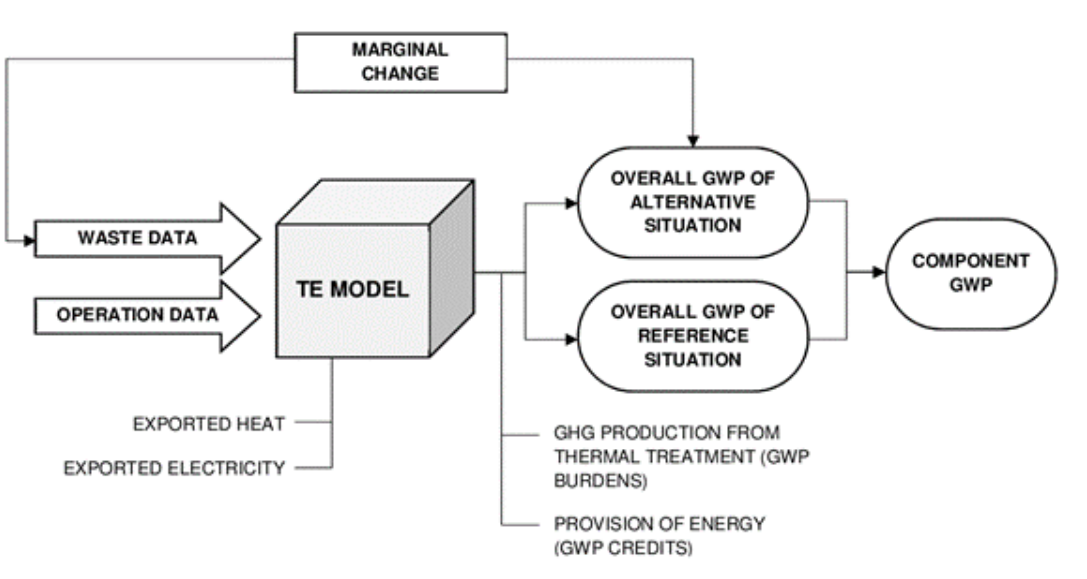
Figure 3. Calculation concept using the marginal change approach to evaluate GWP related to processing components of residual waste (RES) in waste-to-energy (WtE).